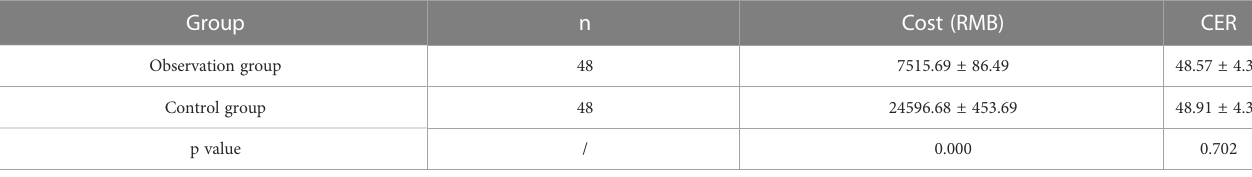
Data are displayed as mean ±